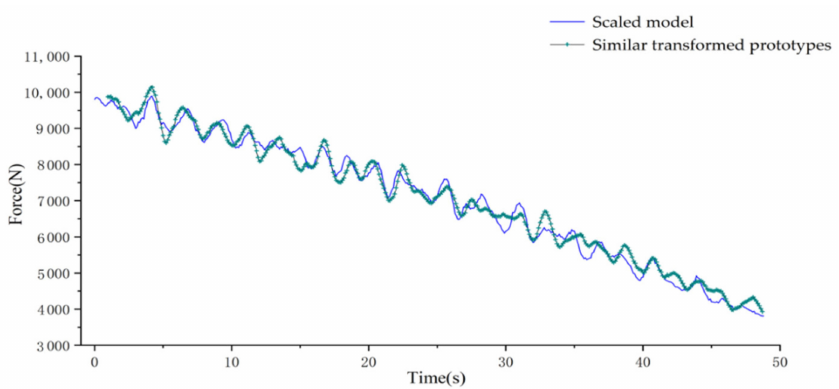
Figure 14. Comparisons of forces at articulated joints of tower and angle adjustment